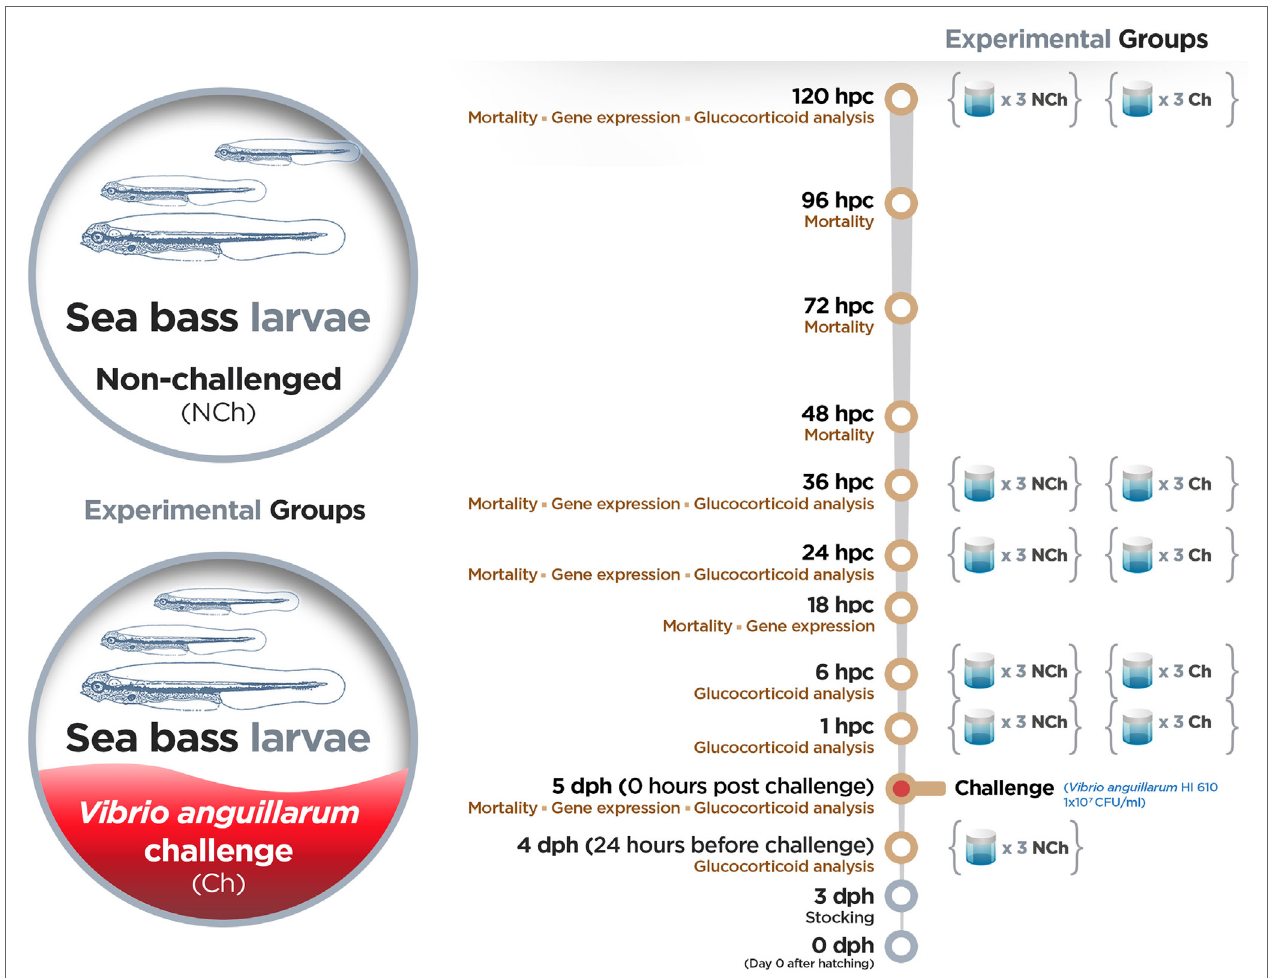
FigUre 1 | Experimental